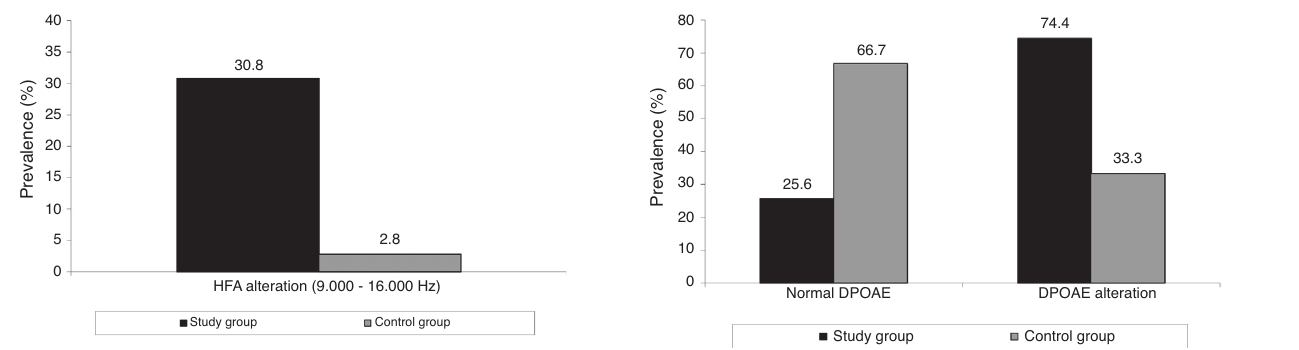
DPOAE in study and control groups. DPOAE, distortion-product otoacoustic emissions.